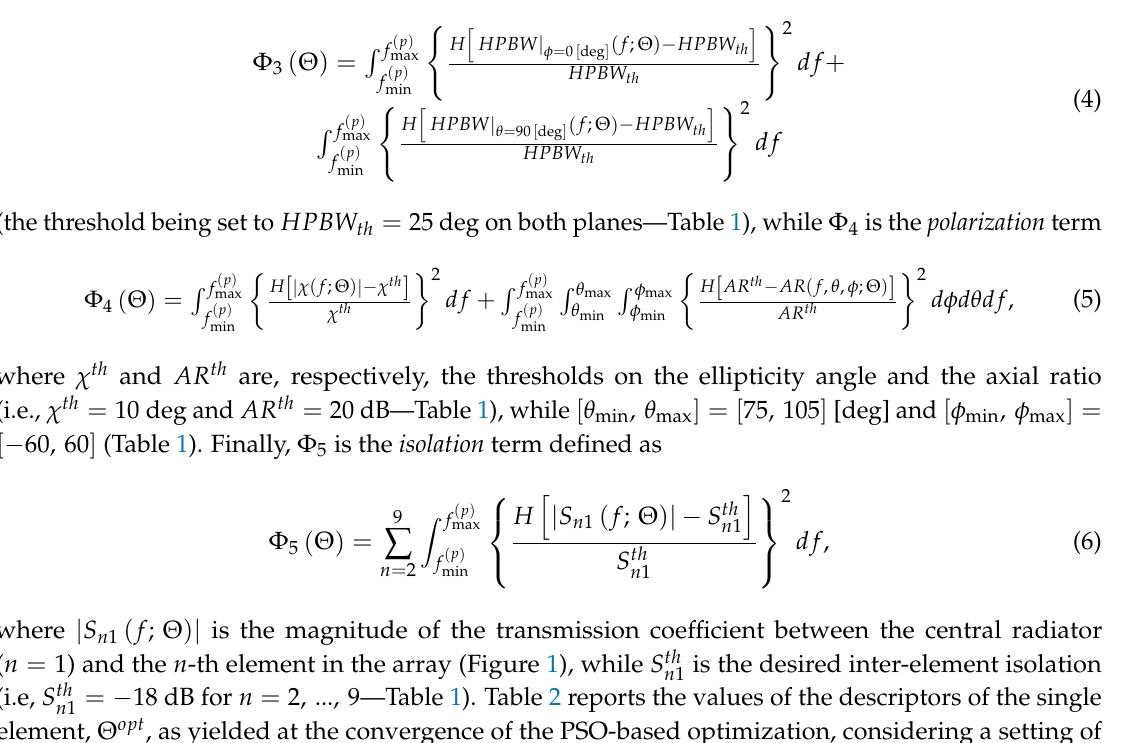
(cid:104) (cid:105) ( s 1 ) ( s 1 ) = [ 31.0, 38.0 f , f max min